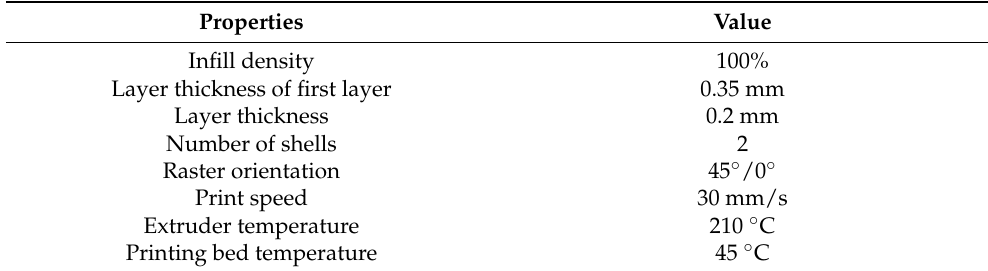
Table 3. Printing parameters of FFF 3D printing for XRD, DMA, WCA, and compression specimens of PLA and PLA/MMT